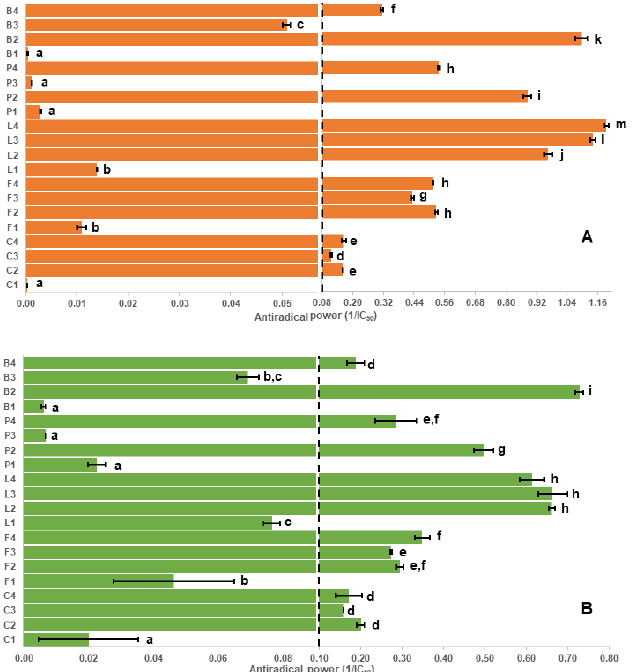
Figure 1. Antioxidant capacity of different genotypes of pulse seed coats measured by DPPH ( A ) and TBARS ( B ) assays. Letters on y-axis refer to different pulse crops; C: chickpea, F: faba bean, L: lentil, P: pea and B: common bean, whereas numbers refer to different seed coat colors. For example, L2 refers to black seed coats of Indianhead lentil (see Table 3, Section 3.1 for code). ARP: antiradical power; ARP is the reciprocal of IC 50 . Bars with different letters for each assay are significantly dif- ferent ( p < 0.05).